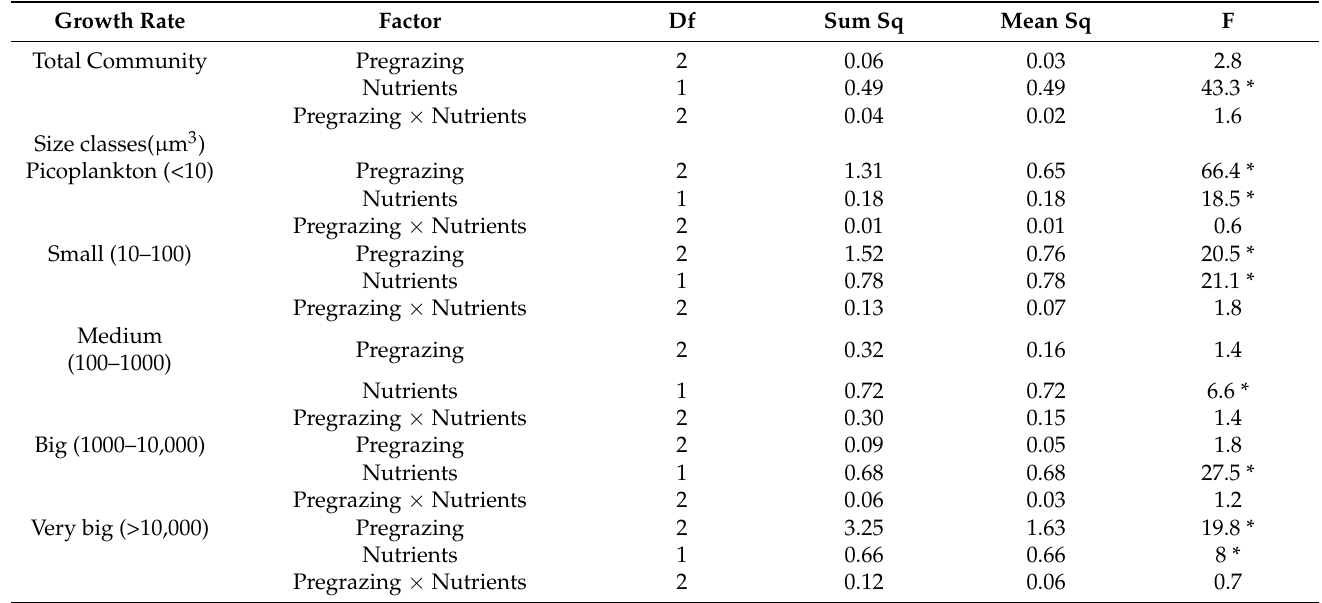
Table 1. ANOVA results showing short-term effects (days 1–3) of factors pregrazing, nutrient addition and interaction between them on mean community growth rate and growth rate of size classes. * = p < 0.05. Growth